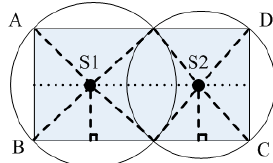
Figure 6. Calculation process for determining the sink wireless range.